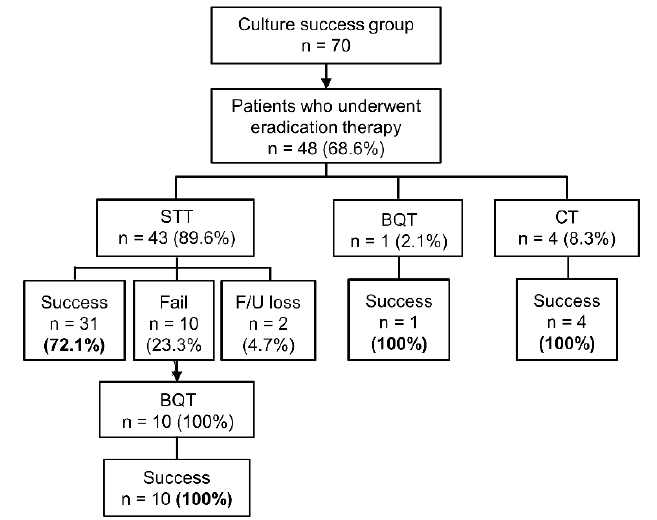
Figure 3. Eradication results of the patients in the culture success group (n = 70). STT, standard triple therapy; BQT, bismuth quadruple therapy; CT, concomitant therapy (proton pump inhibitor + amoxicillin + clarithromycin + metronidazole).